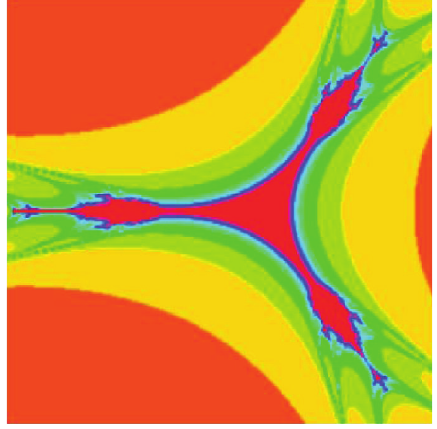
Figure 3: Relative superior tricorn for 𝑠 = 0.4 and 𝑠 󸀠 = 0.3